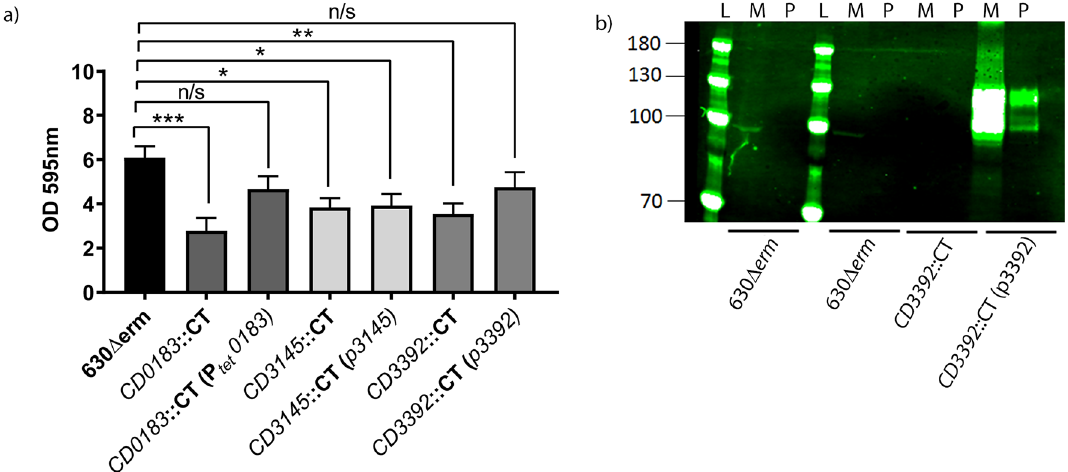
Figure 5. Cell wall proteins involved in biofilm formation. ( a ) Insertional inactivation mutants of non-c-di- GMP regulated proteins CD0183, CD3145 and CD3392 were created in C. difficile strain 630Δ erm . Mutants were complemented by introduction of plasmids expressing the wild type gene. These mutants and their complements were assessed for their ability to form early biofilms (24 h) on an abiotic surface in vitro compared to a wild-type control. Crystal violet assays were performed with a minimum of 6 biological replicates. All error bars are SD. Statistical differences were assessed using linear regression to compared to all strains against their respective parent strain 630Δ erm , *p < 0.05, **p < 0.01, ***p < 0.001. ( b ) Western blot using anti CD3392 antibodies of the matrix (M) and planktonic fractions (P) of a late biofilm, from strains 630Δ erm , CD3392 ::CT and CD3392 complement ( CD3392 ::CT (p CD3392 )). The biofilm matrix was detached from the bottom of a TC flask, disrupted by the addition of DNase (100 µg/mL), then loaded onto an SDS-PAGE gel alongside a